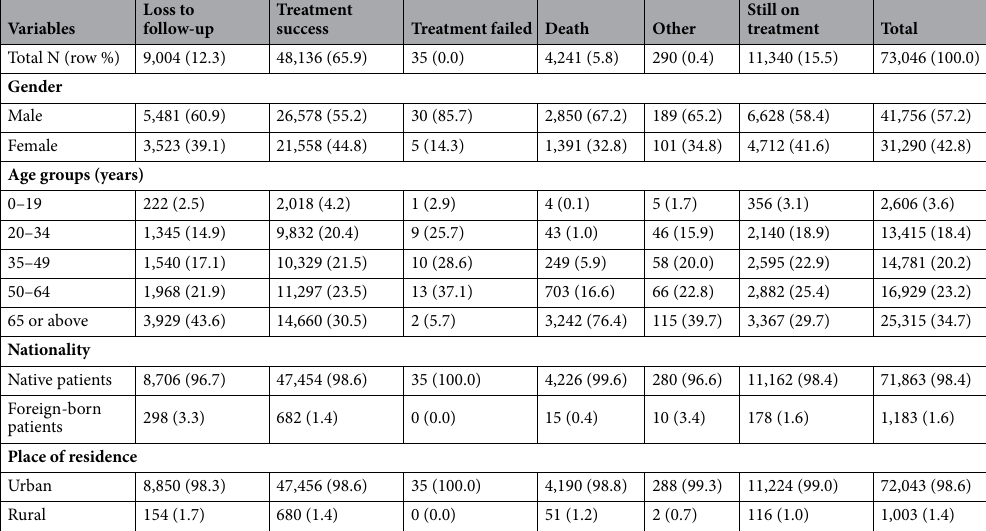
Table 2. Baseline demographic characteristics of enrolled tuberculosis patients, categorized by treatment outcome. a Composed of ‘treatment after failure patients’ and ‘other previously treated patients’ whose outcome of previous treatment was unknown or undocumented. b Patients with pulmonary tuberculosis were analysed. N number, LTFU loss to follow-up; Data are presented as n (column